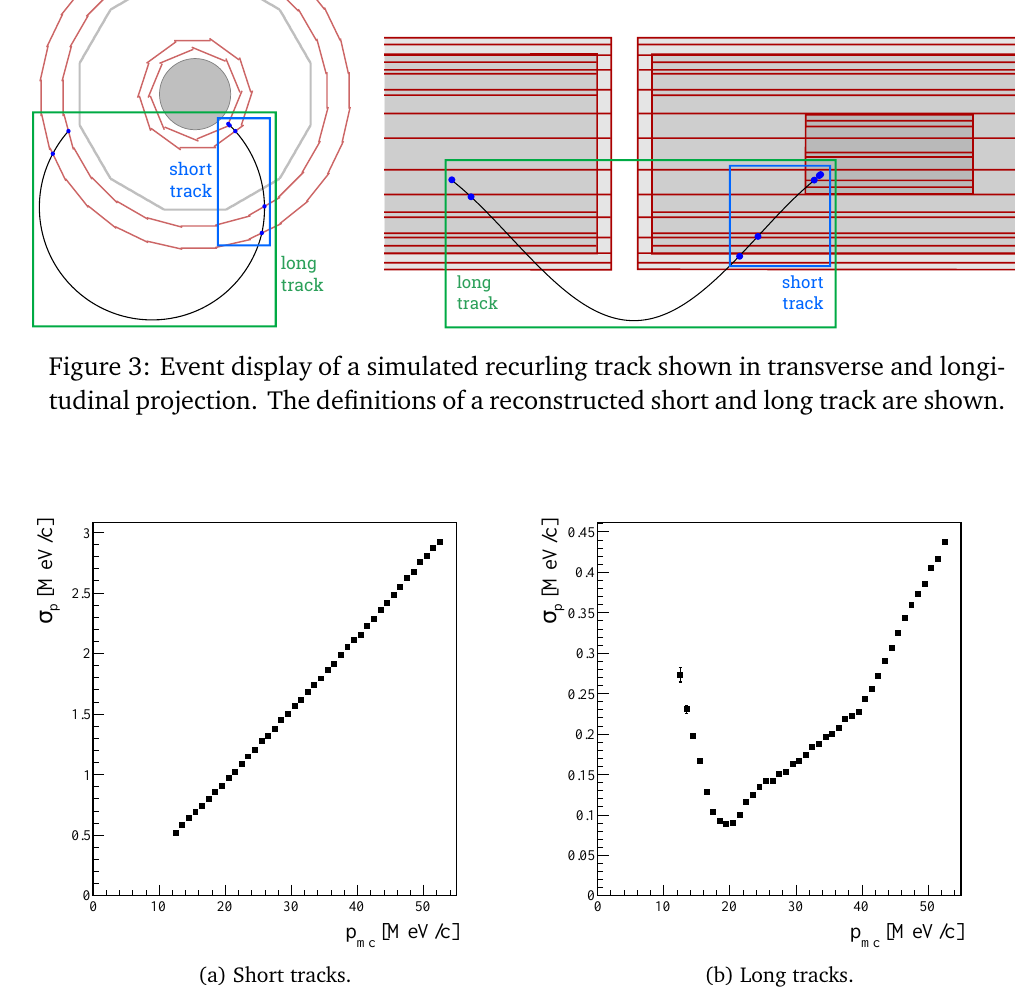
Figure 4: Momentum resolution of reconstructed short and long